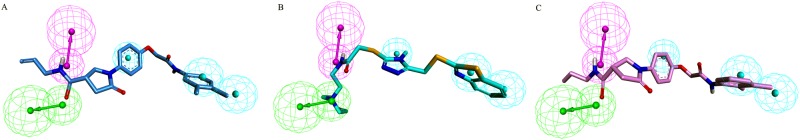
Hypo1 mapped onto the hit compounds.A) Hit 1, (B) Hit 2, (C) Hit 3. The HBAL, HBD and HYP features are displayed in green magenta and cyan, respectively.